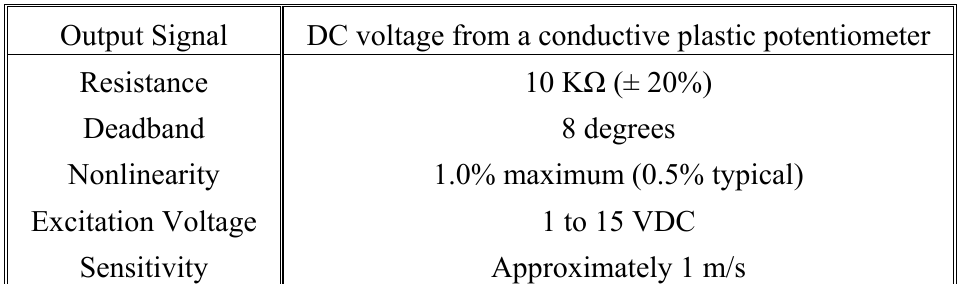
Table 1. Specifications for the NRG #220P wind direction